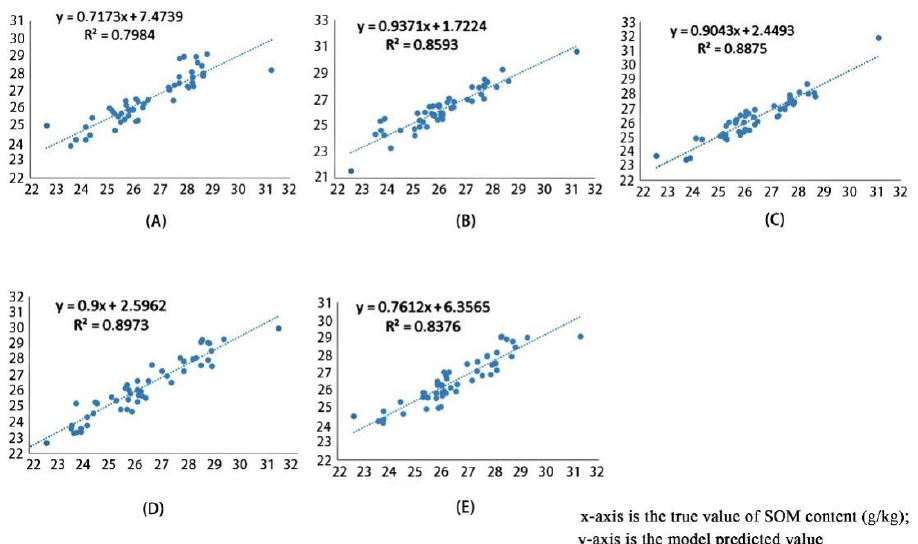
Figure 9. R 2 of the true and predicted values with different number of features: ( A ) inversion results